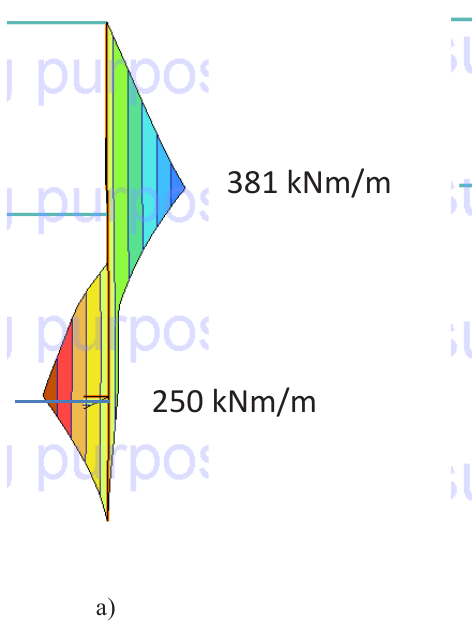
Figure 15: Envelopes of the bending moments in the diaphragm wall: (a) flood after baseplate installing and (b) flood before baseplate